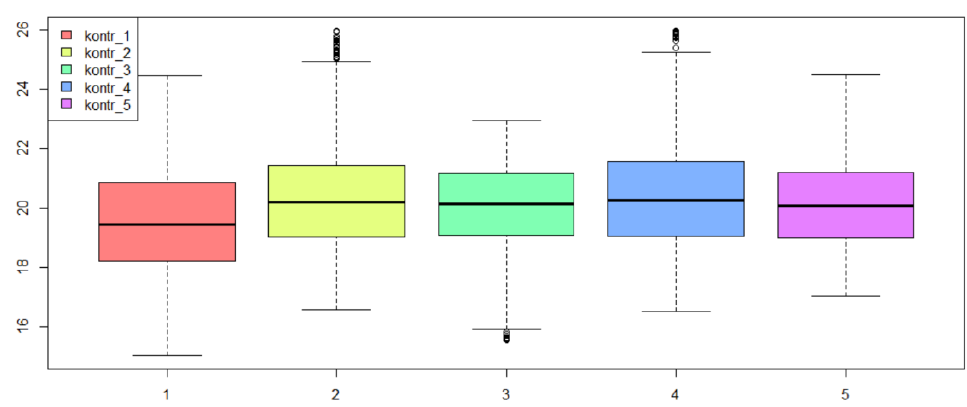
Figure 11. Humidity content by contractor.